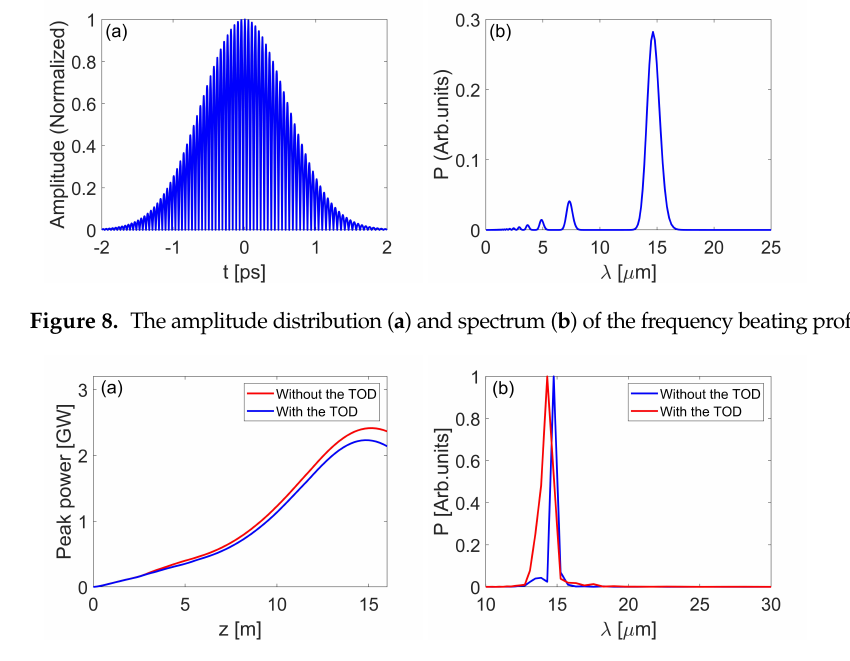
Figure 9. The evolutions of peak power ( a ) and spectra ( b ) of the THz radiation with or without the